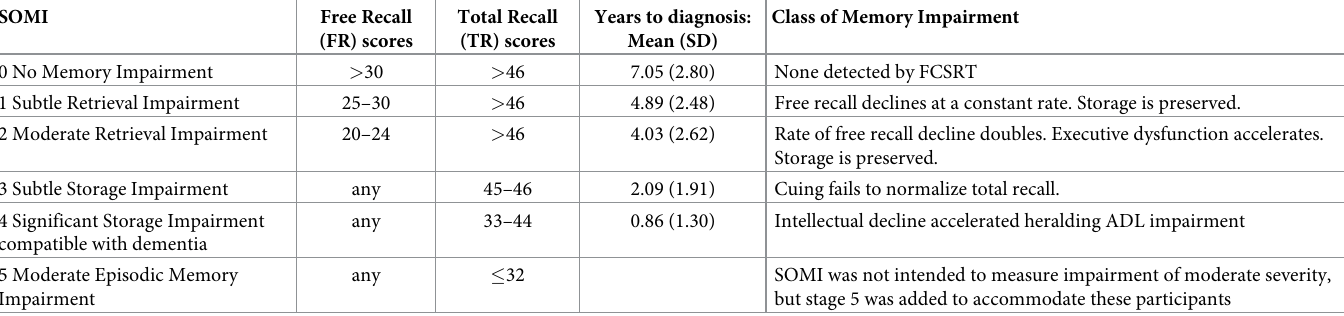
Table 1. Stages of Objective Memory Impairment (SOMI) defined by free recall and total recall score ranges and years to diagnosis [39].